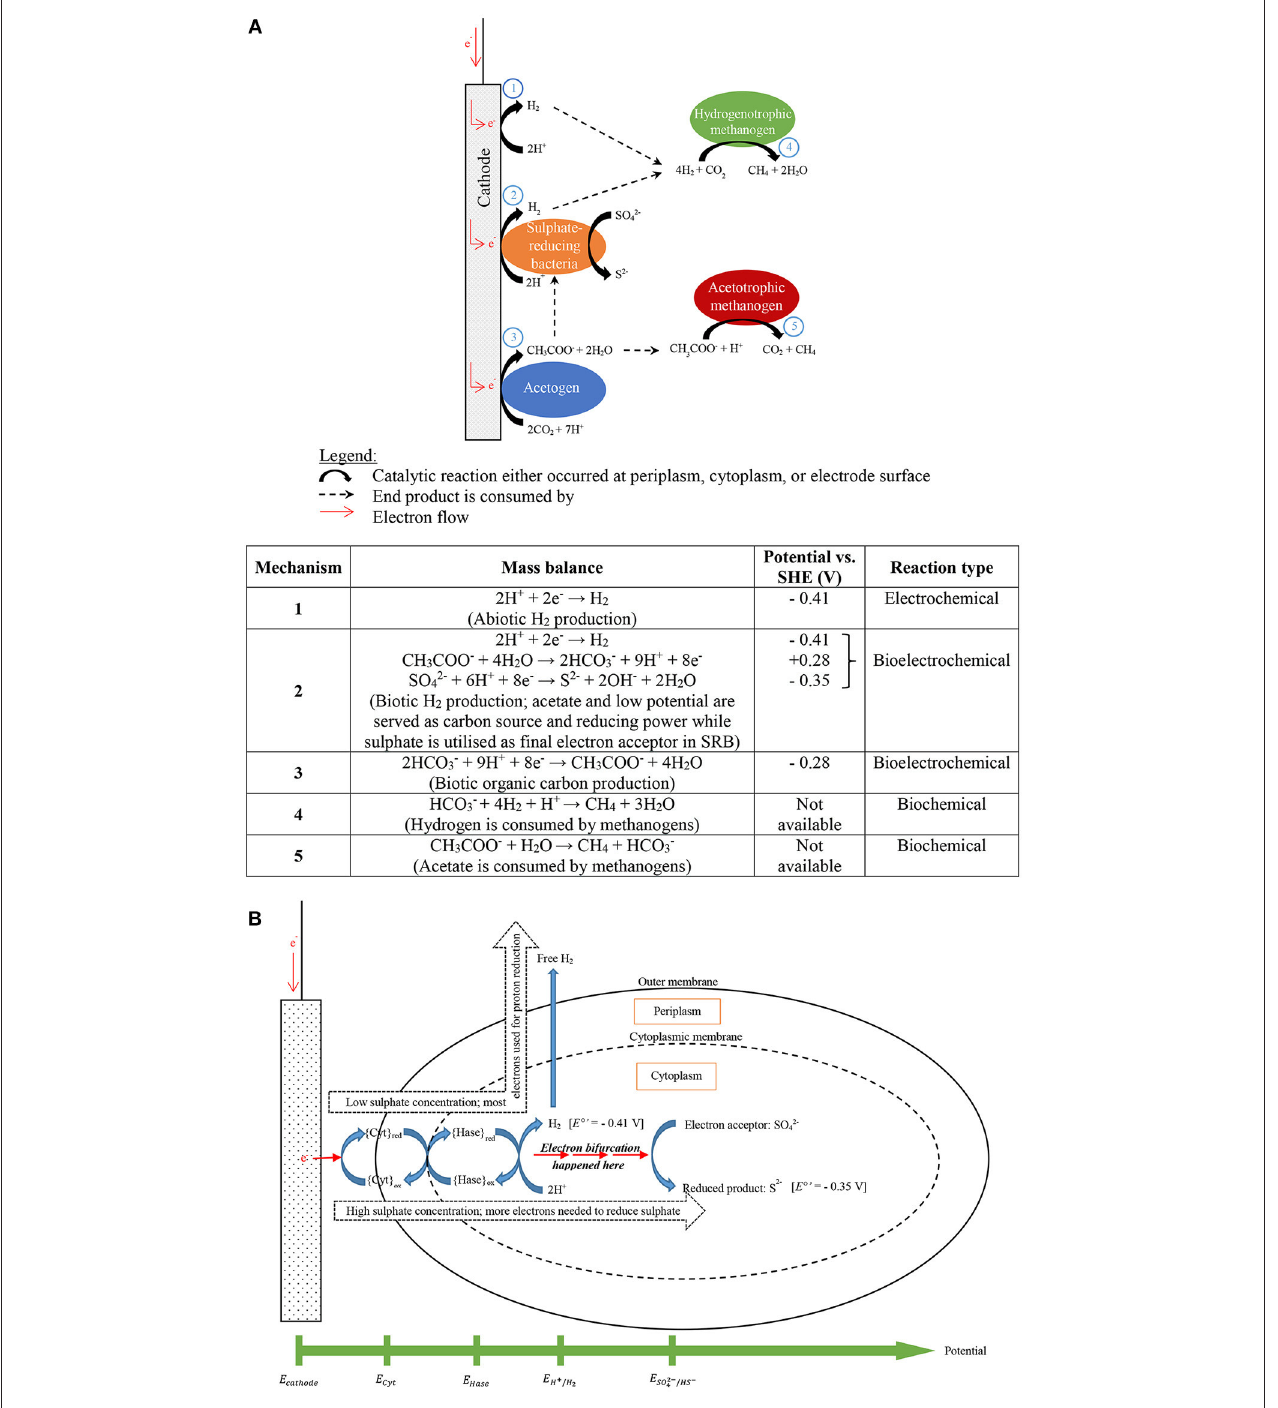
FIGURE 8 | (A) Proposed electron flow and possible final destinations of the supplied electrons being utilized in producing various end products (modified after Mand et al., 2014), (B) description of electron bifurcation flow in sulfate-reducing bacteria-dominated biocathode to generate hydrogen and reduce sulfate.